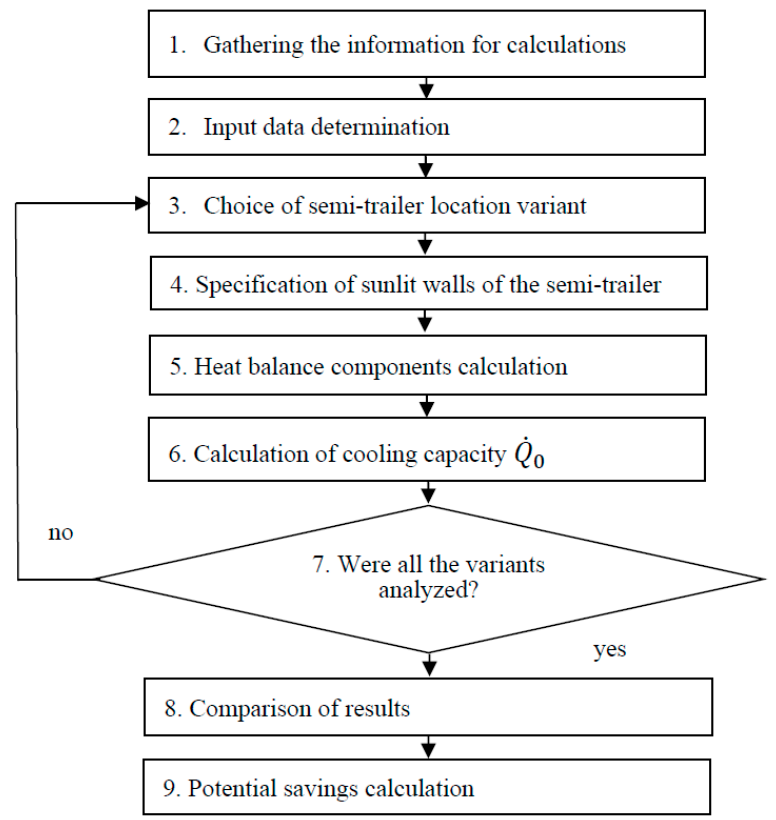
Figure 2. A simplified algorithm to determine the total heat loads to evaluate the savings associated with the energy consumption.